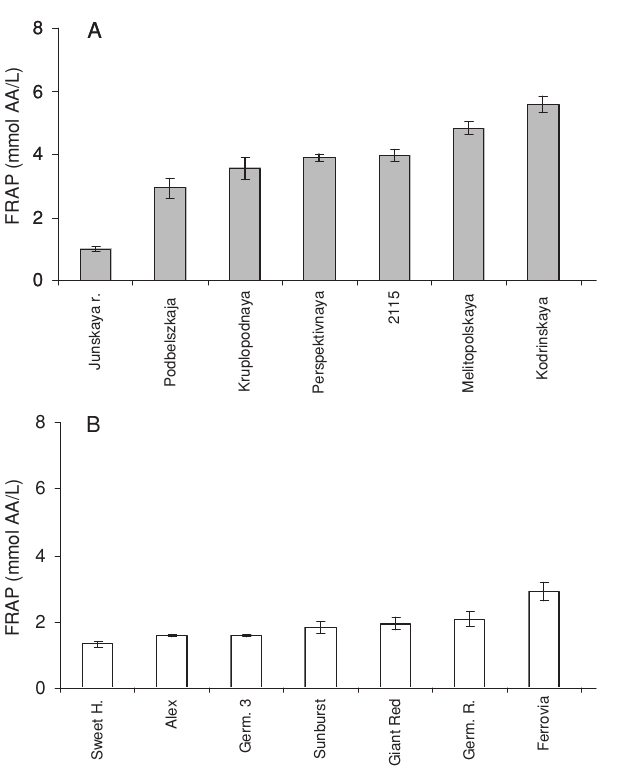
Figure 2: Total phenolics content of Ukrainian (A) and commercial (B) sweet cherry cultivars in 2009, Szigetcsép,